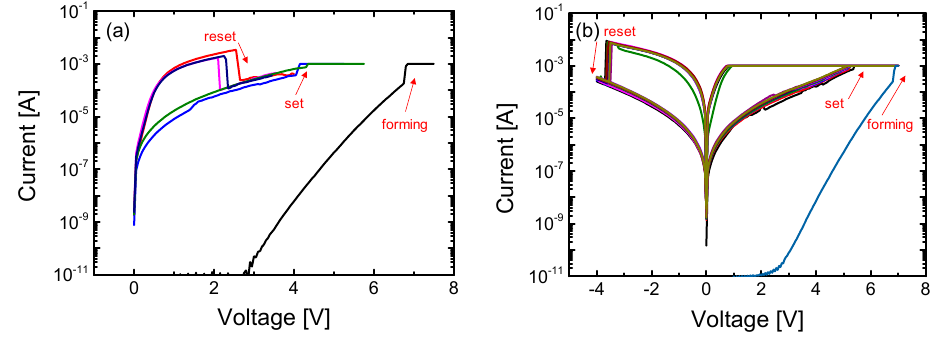
Figure 2. DC current-voltage (I-V) characteristics of the Ni/SiN x /n ++ Si resistive-switching random access memory (RRAM) device for ( a ) unipolar switching and ( b ) bipolar